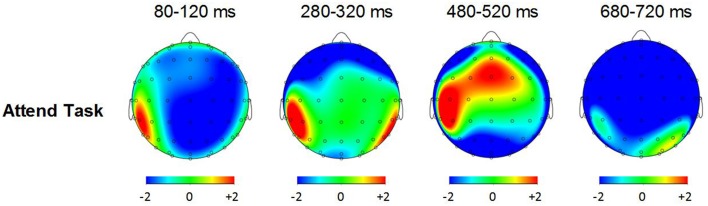
Voltage (in μV) scalp topographies showing the time course of the difference between deviant beat omissions and corresponding standard target beats for Mathieu in the attend task.